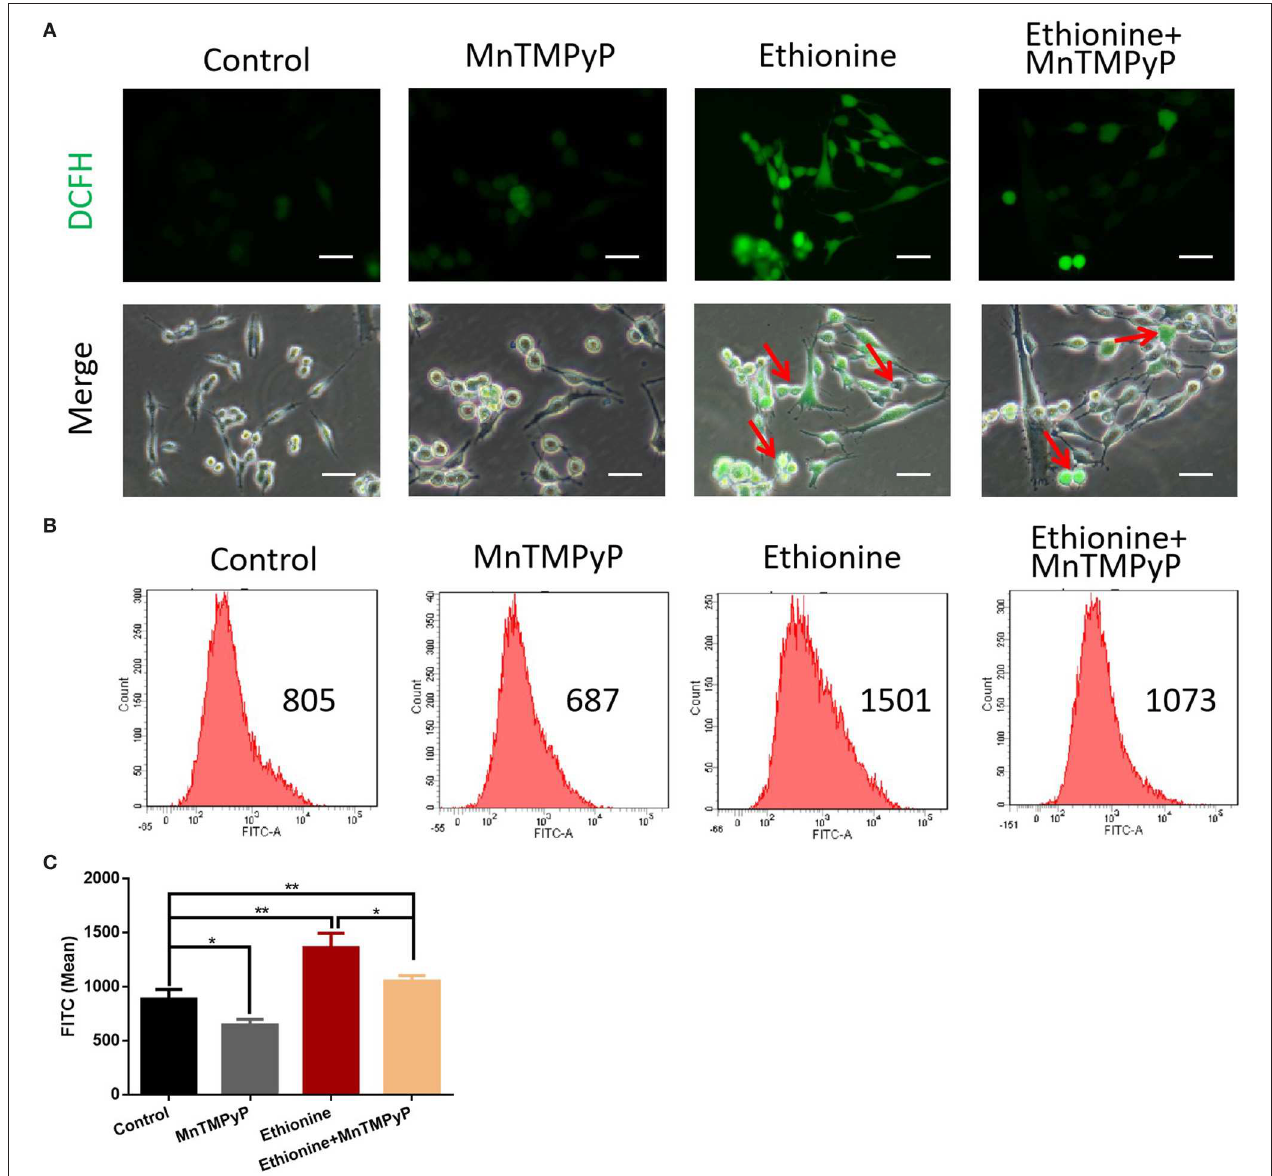
FIGURE 4 | Ethionine induced reactive oxygen species. (A) HT-22 cells were treated with ethionine and MnTMPyP, and ROS levels were determined using DCFH-DA. Representative images are shown. Scale bars: 100 µ m. (B) Changes in intracellular ROS generation was assessed using DCFH-DA by flow cytometry. (C) Quantification of ROS analysis. One-way ANOVA followed by LSD t -test were used for difference compared with other groups. * P < 0.05 and ** P <